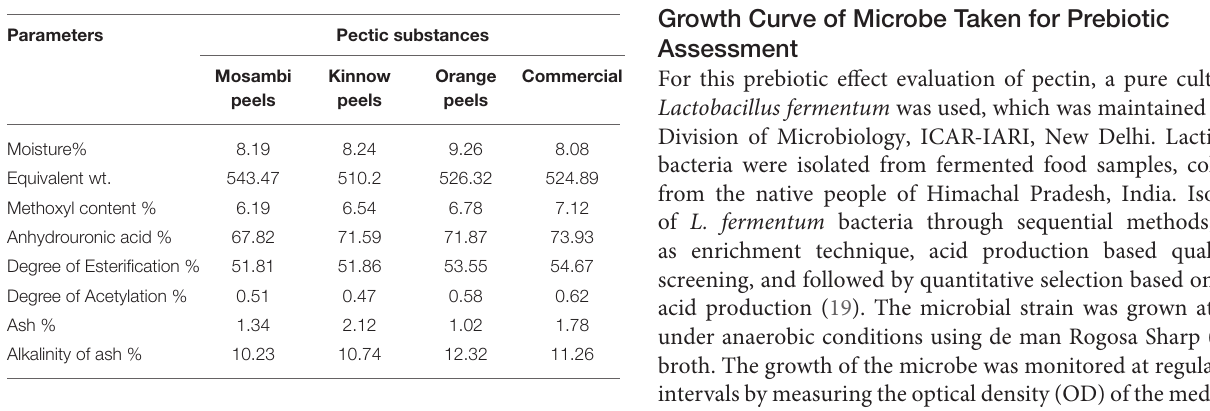
TABLE 2 | Physicochemical parameters of pectins extracted from three Citrus